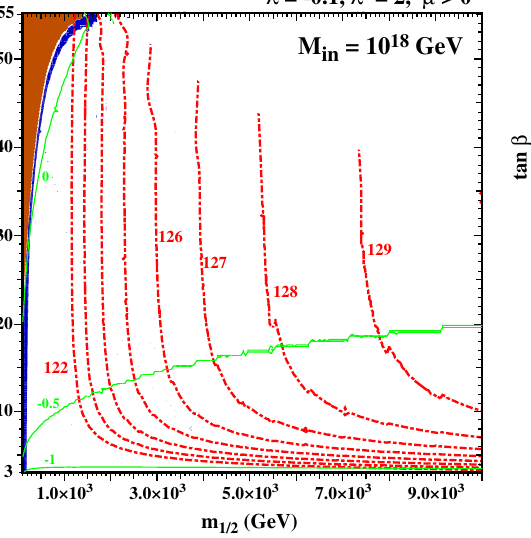
Fig. 1 Sample no-scale super-GUT ( m 1 / 2 , tan β) planes for M in = 10 18 GeV. In the left panel λ = − 0 . 1 and λ (cid:2) = 2, whereas in the right panel λ = 1 and λ (cid:2) = 10 − 5 . The brown shaded region has a stau LSP. The regions compatible with the relic density determined by Planck and other experiments are shaded dark blue , and the red dot-dashed curves are contours of constant Higgs mass as calculated using FeynHiggs ,